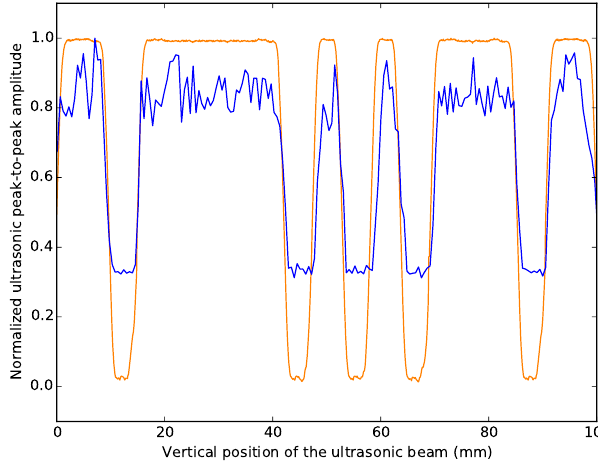
Fig. 13. One-dimensional C-scan of the amplitude of the sodium experiment. Orange: CIVA simulation, blue: experiment.